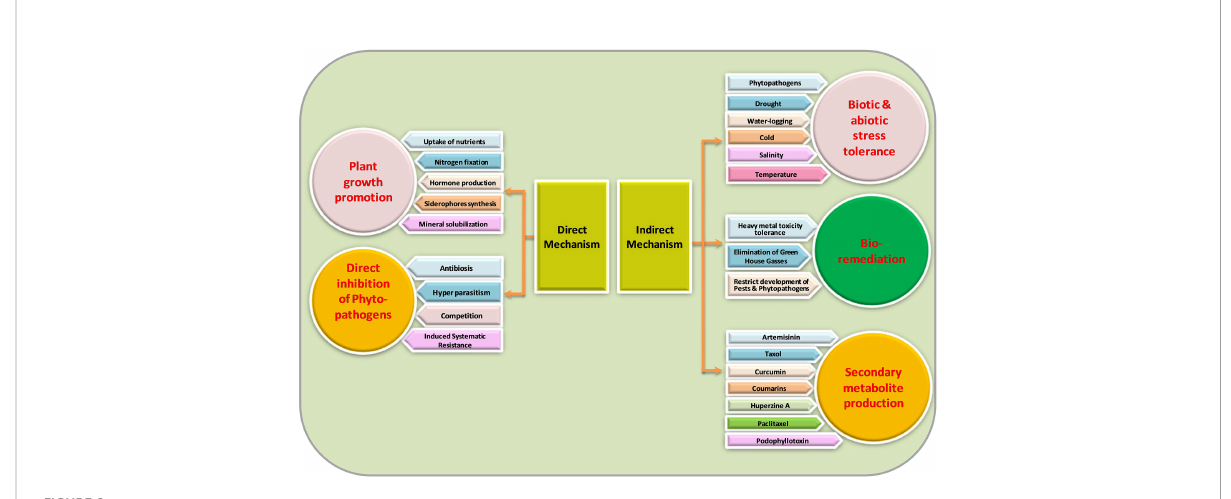
FIGURE 2 Mechanism of action of endophytic